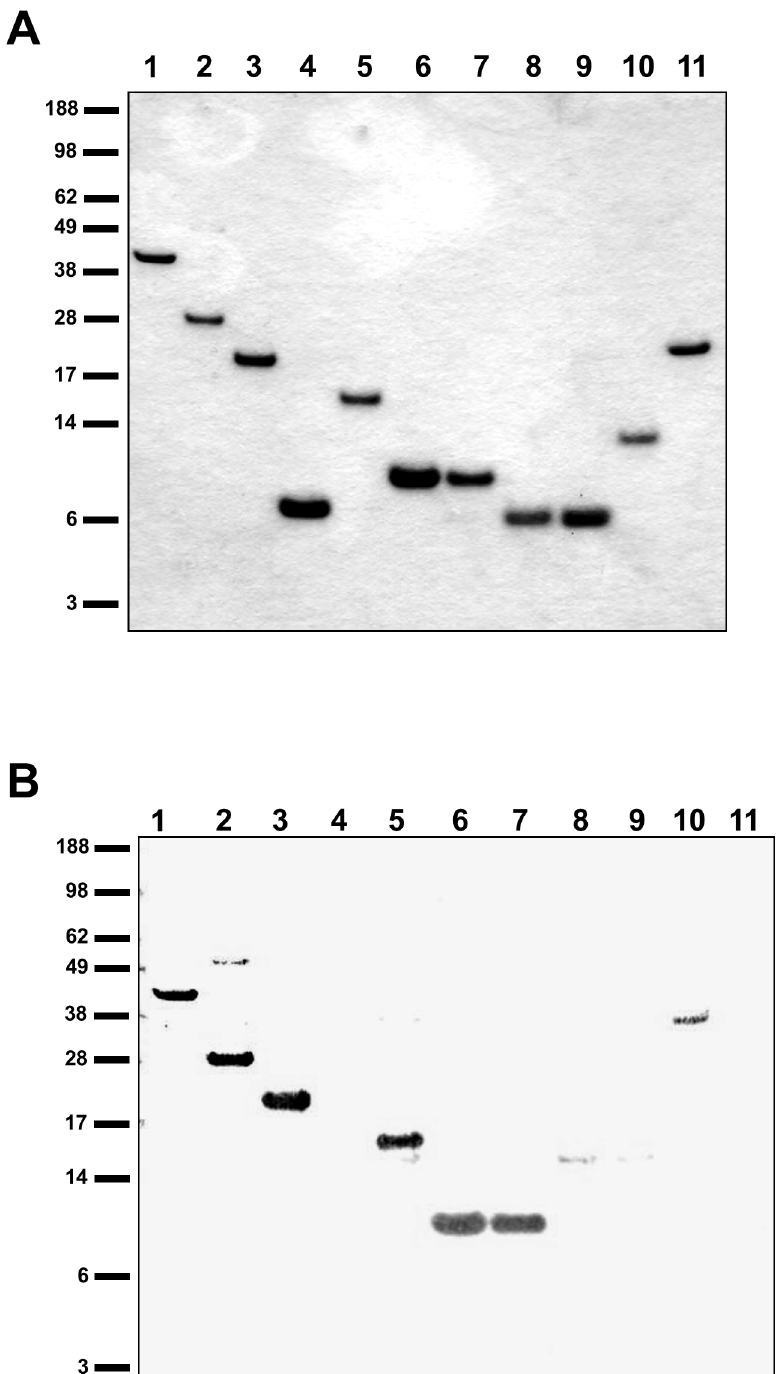
Fig 2. DNA binding activity of PilG full-length and partial recombinant proteins. (A) Coomassie Blue- staining of recombinant proteins separated by SDS-PAGE. Lane 1, PilG FL/1-410 ; lane 2, PilG 1-256 ; lane 3, PilG 1-178 ; lane 4, PilG 1-60 ; lane 5, PilG 1-140 ; lane 6, PilG 1-80 ; lane 7, PilG 1-81 ; lane 8, PilG 30-80 ; lane 9, PilG 30- 81 ; lane 10, PilG 257-410 ; lane 11, PilG 166-410 . (B) Solid phase overlay assay of the proteins shown in A. Similar results were obtained with all DNA substrates employed (see Table 2). Additional bands in lane 2, 8 and 10 constitute E . coli contaminants due to differences in purity between the recombinant proteins. The positions of the protein size standards (kDa) are shown on the left.